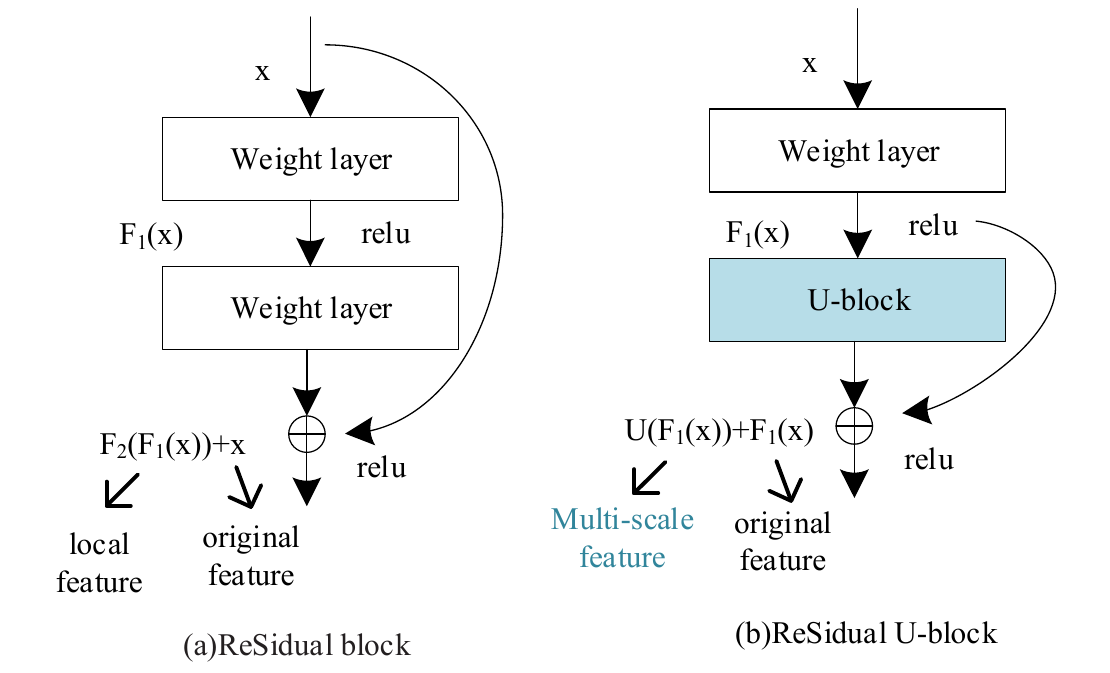
Figure 2. Basic structure of the residual module ( a ) residual module ( b ) residual U block.